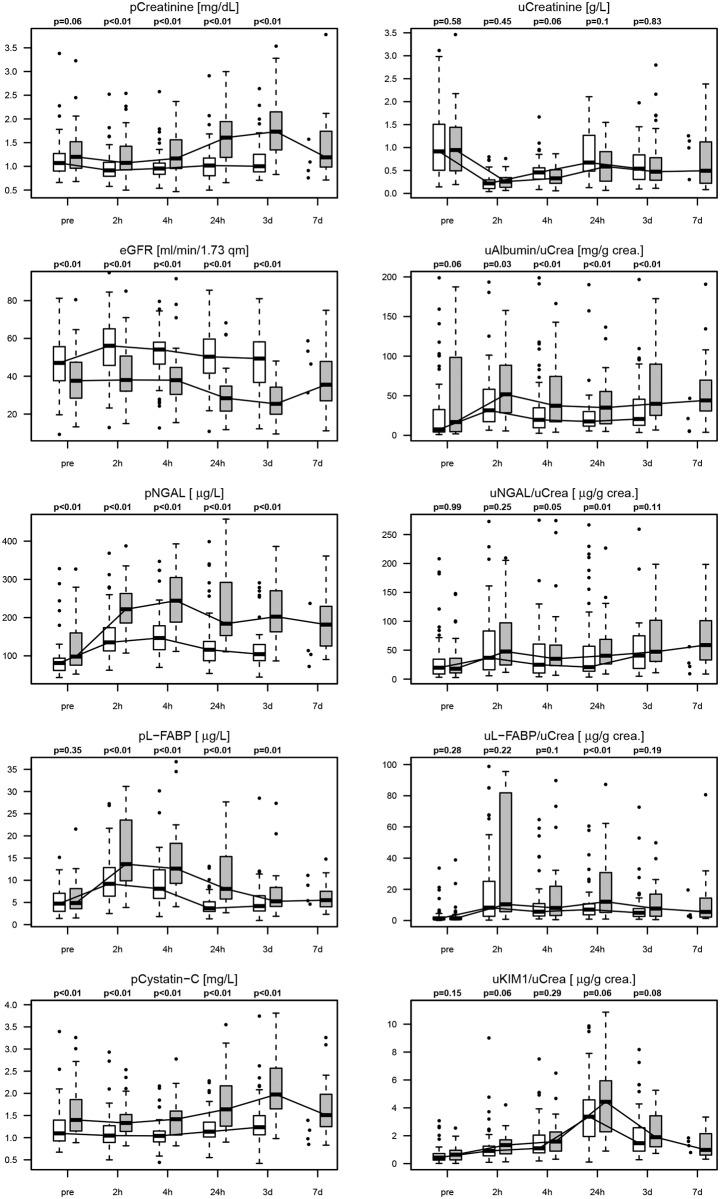
Renal biomarkers in plasma and urine.Time course box blot analysis for plasma (left columns) and urinary (right column) biomarkers including creatinine, eGFR, albumin, NGAL, L-FABP, cystatin C and KIM1. Bright columns (left at each time point) represent non-AKI patients, dark columns (right at each time point) AKI patients. Biomarkers in urine are normalized to urinary creatinine (uCrea). Boxplots display median, 25th and 75th percentiles. The unadjusted p-values of Wilcoxon rank-sum test are depicted above the boxplots.